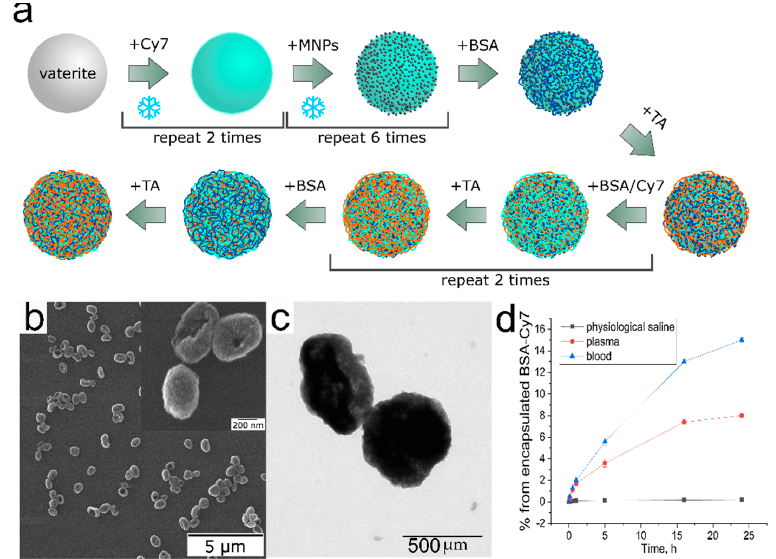
Figure 1. Scheme of the carrier synthesis and freezing induced loading ( a ), SEM ( b ), TEM ( c ) images, and the effect of various biological fluids on stability of MNPs (BSA ‐ TA) ( d ).